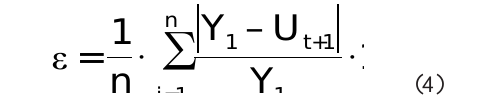
), N – number of the Cooper 2